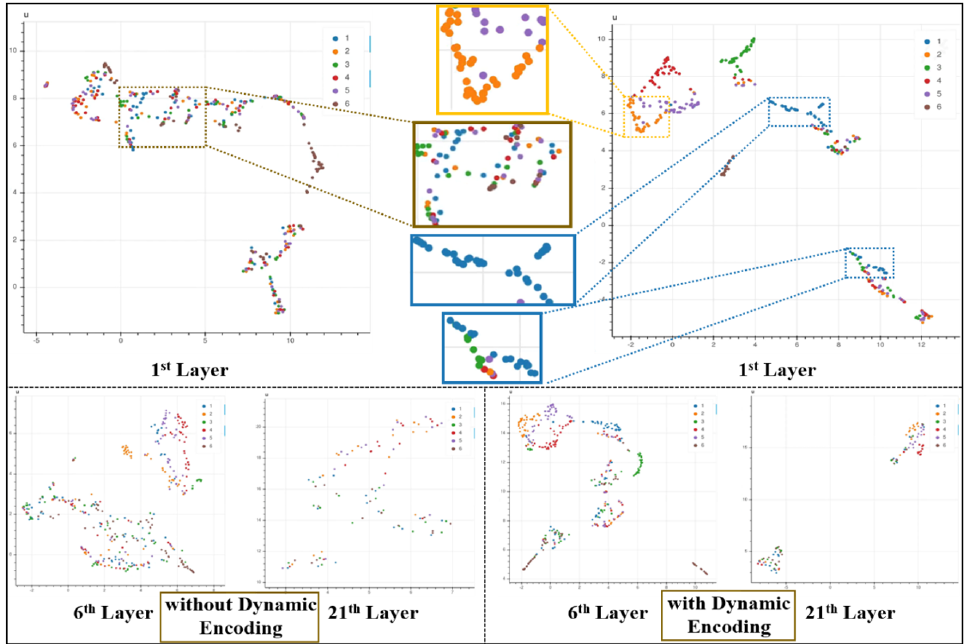
Figure 6. Comparison of data separability before and after adaptive